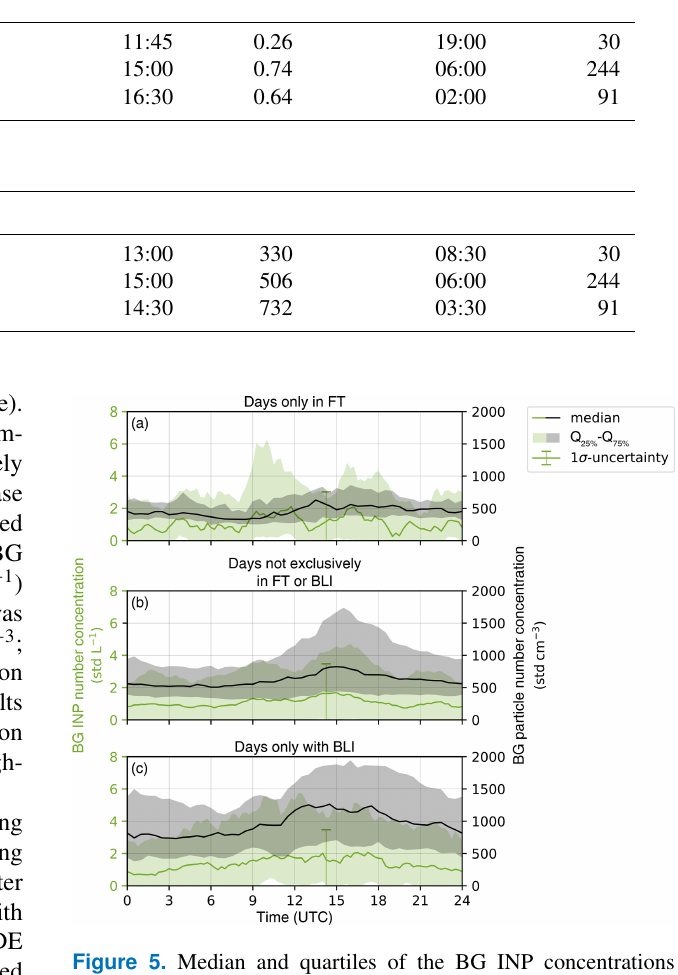
Figure 5. Median and quartiles of the BG INP concentrations (green) and BG particle number concentrations (gray), phase- averaged with a cycle period of 24h, starting at 00:00UTC of each day between February 2020 and January 2021, for measurements from days only within the FT (a) , for days not exclusively in FT or BLI (b) , and for days only with BLI (c) . Error bars show a σ counting uncertainty of the INP